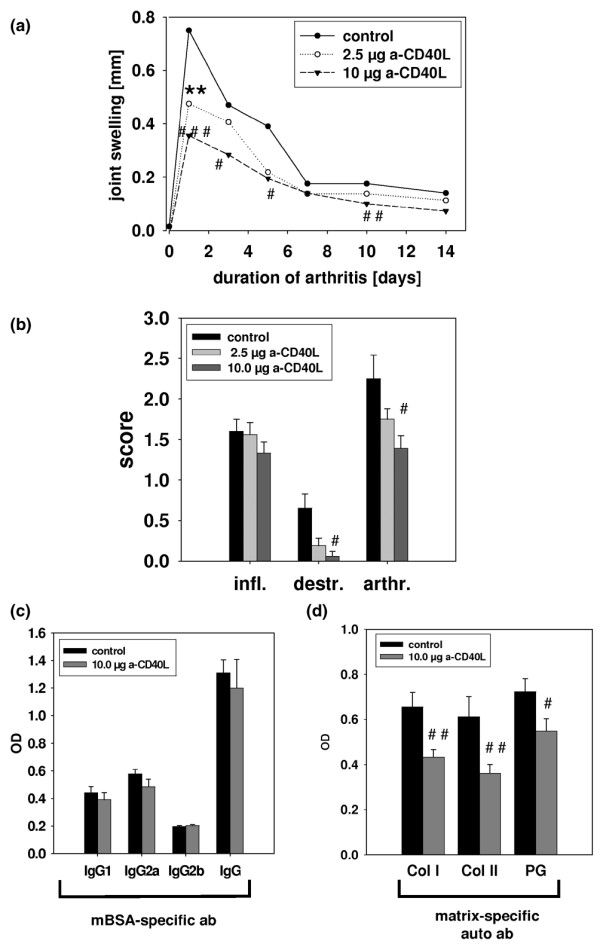
Dose-dependent effects of anti-CD40L monoclonal antibody (a-CD40L) treatment on antigen-induced arthritis. Effects on (a) knee joint swelling and (b) histology (n = 9). Hematoxylin-eosin stained knee sections were evaluated as described in Figure 1. (c,d) Effects on the serum levels of methylated bovine serum albumin (mBSA)-specific IgG isotypes and autoantigen-specific IgGs (against collagen type I (Col I), collagen type II (Col II) and proteoglycan (PG));**P ≤ 0.01, (2.5 μg a-CD40L versus buffer-treated AIA control). #P ≤ 0.05, ##P ≤ 0.01, (10 μg a-CD40L versus buffer-treated AIA control). Infl., inflammation; destr., destruction; arthr., total arthritis score.